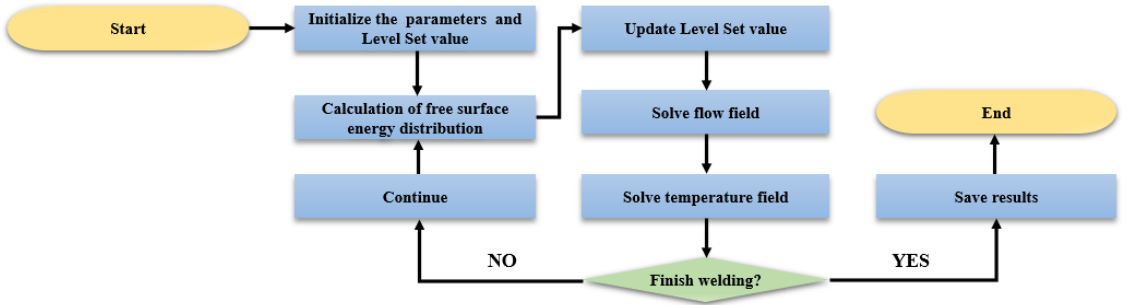
Figure 4. The simulation flow chart of LSMW.